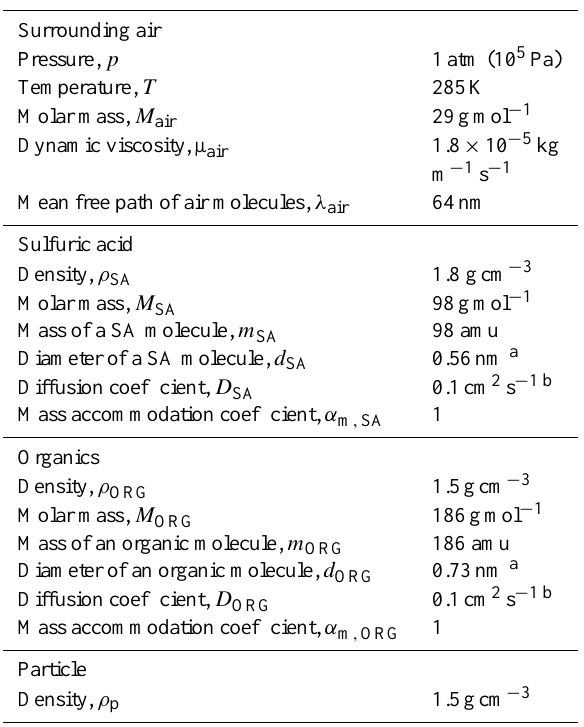
Table 1. Values for parameters used in this study for surrounding air, for condensable vapors (sulfuric acid and organics (SORG MT and SORG bg )) and for